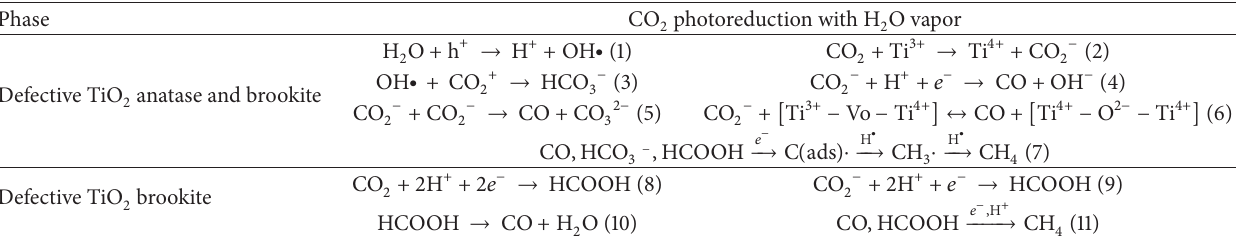
Table 2: Possible reaction pathways for defective TiO